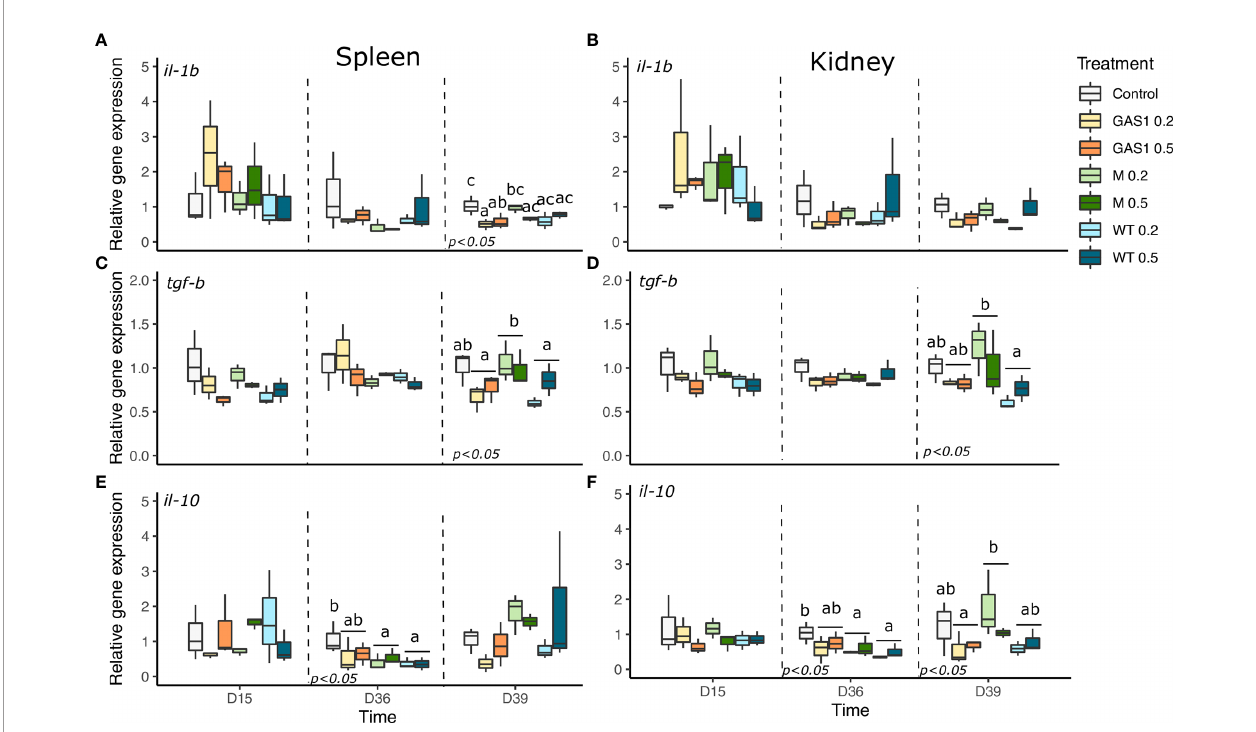
FIGURE 3 | Effects of dietary b -glucan on pro-in fl ammatory gene expressions in spleen and kidney of fi sh sampled during the nutrient test on D15 and D36, or 2 days after the bacterial challenge (D39). (A – F) are expression levels of il-1 b , tgf- b 1 , and il-10 in spleen and kidney, respectively. Relative transcript (mRNA) levels were determined by real-time RT-PCR and normalized by the arithmetic mean of ef-1 a expression. Values are expressed as mean ± SD of three pool samples per experimental condition (3 fi sh per pool sample). Statistical differences, highlighted by letters, are indicated for glucan concentrations in front of 0%, 0.2%, and 0.5% next to the corresponding plot, for glucan type by letter above the horizontal bar grouping the two doses of the same glucan, for glucan type × concentrations interactions above each box. P values are shown at the bottom of each graph at a given time point (D15, D36, or